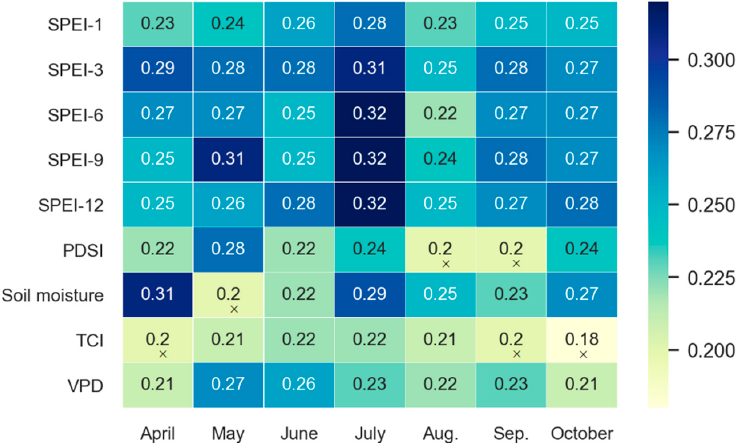
Figure 10. Comparison of the correlation coefficients between SIF and drought variables in each month of growing season for alpine grasslands. The symbol × represent significant correlations (0.01 < P < 0.05). The correlation without symbol × were significant at 1% level.